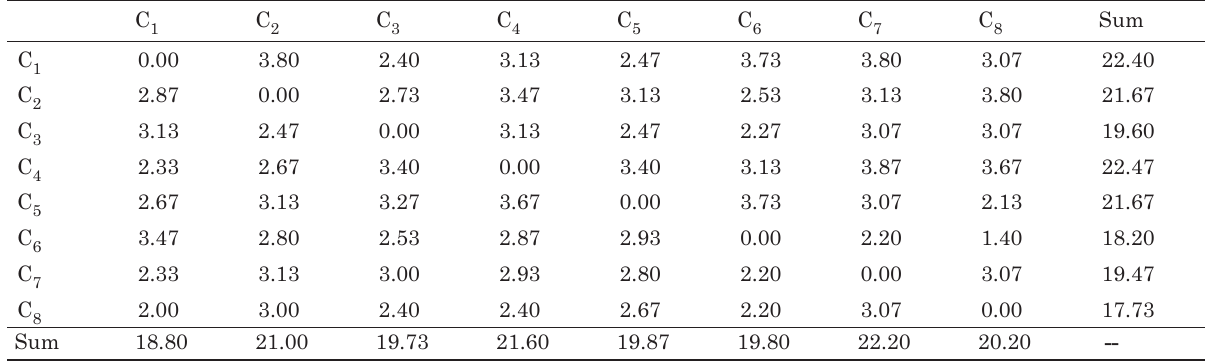
Table 6. Average